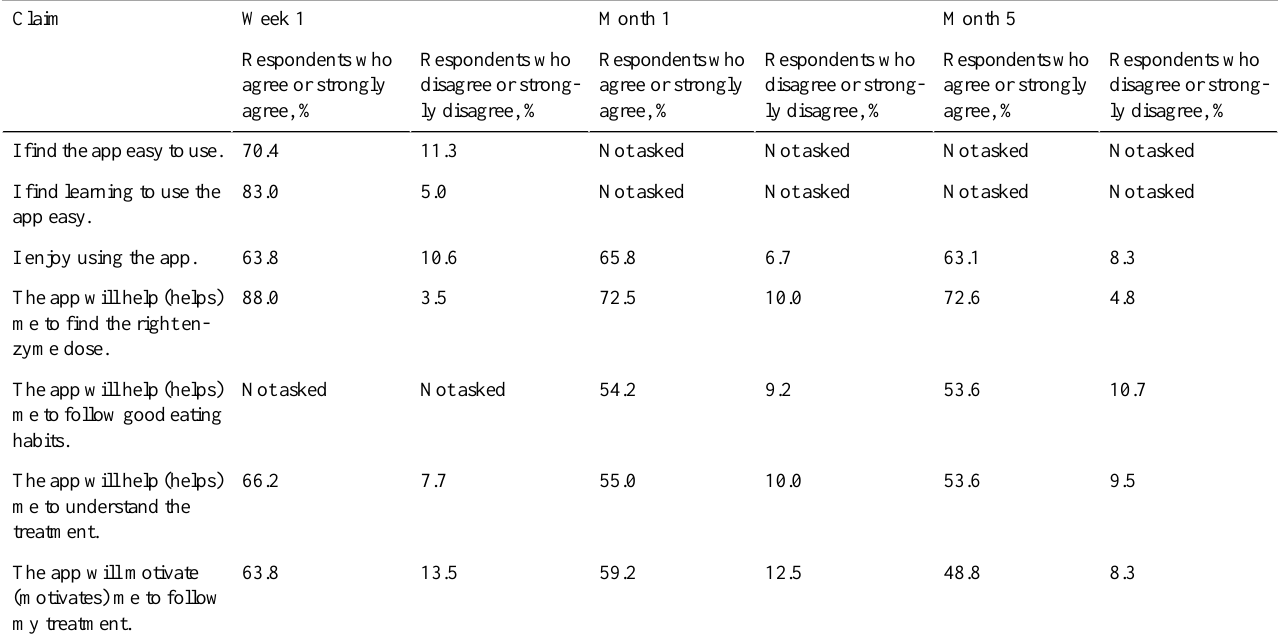
Table 8. Percentage of respondents who agree or strongly agree with the claim and those who disagree or strongly